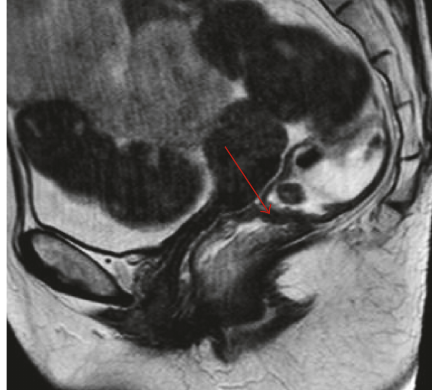
Figure 5: Postevacuating MR image showing thickening at the anastomotic line (arrow) and trapping of contrast in the segment cranial to it.